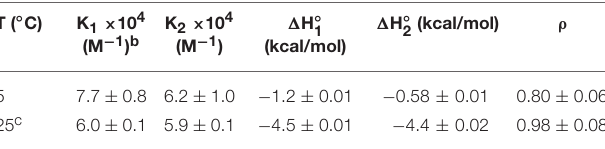
TABLE 1 | Thermodynamic parameters for binding of dUMP to TSase a . T ( ◦